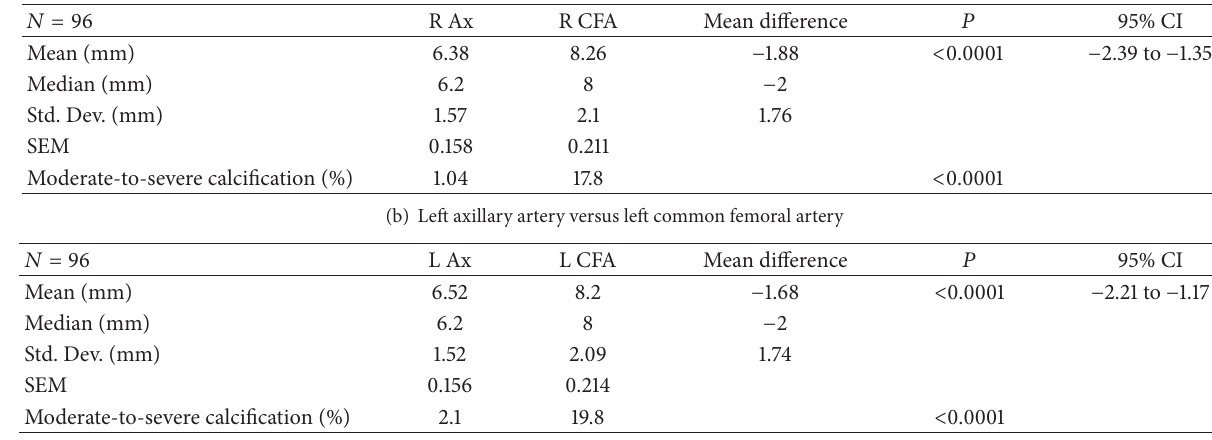
Figure 5: Diagrammatic representation of the size of the axillary arteries in comparison to common femoral arteries. Table 2: Diameters of the axillary versus common femoral